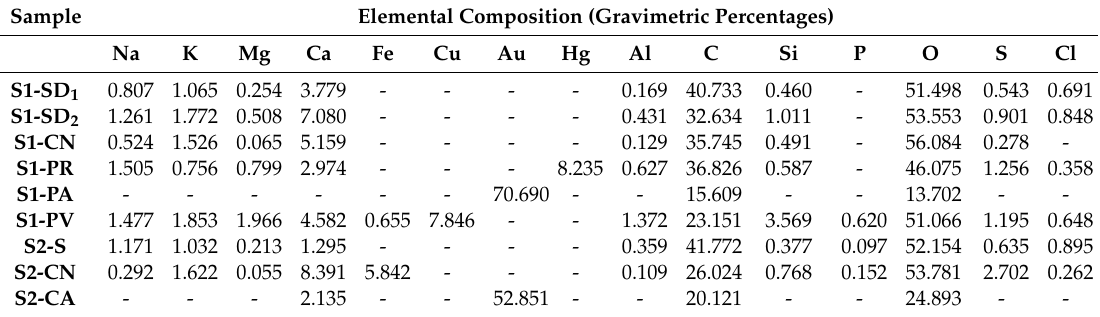
Table 1. The elemental composition in gravimetric percentages for the samples collected from the two documents under scrutiny and indexed according to the area and type of